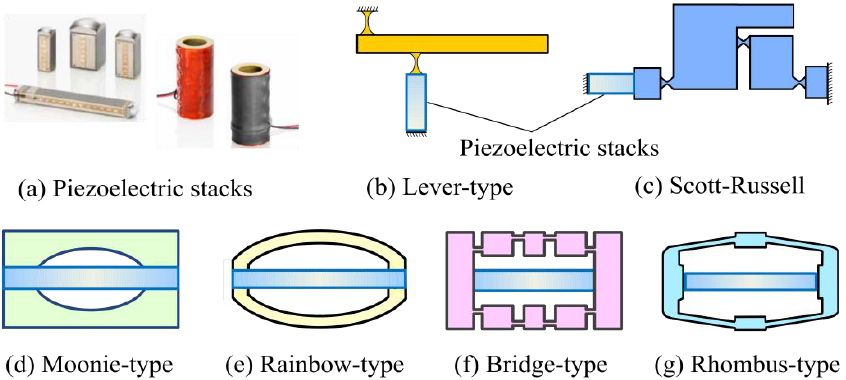
Figure 1. Picture of piezoelectric stacks and schematic diagram of common types of mechanically amplified piezoelectric actuators by compliant mechanisms. ( a ) Piezoelectric stacks; ( b ) Lever-type; ( c ) Scott-Russell; ( d ) Moonie-type; ( e ) Rainbow-type; ( f ) Bridge-type; ( g ) Rhombus-type.